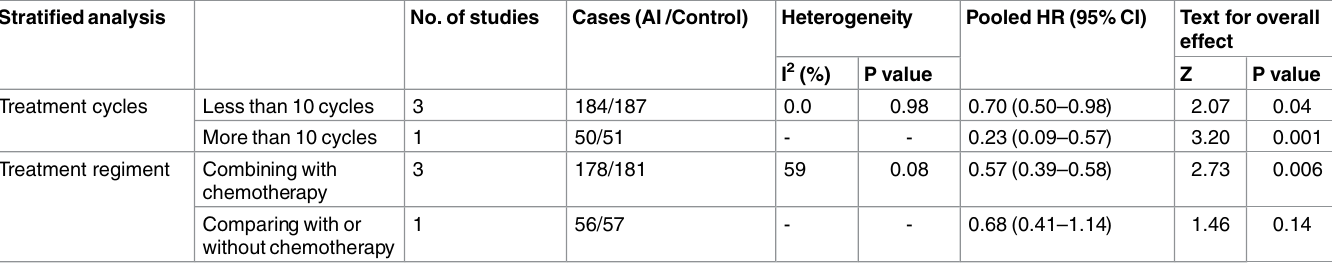
Table 3. Resultsof subgroupanalysisaccording to treatmentline,treatmentregimensfor Meta-Analysis. Stratified